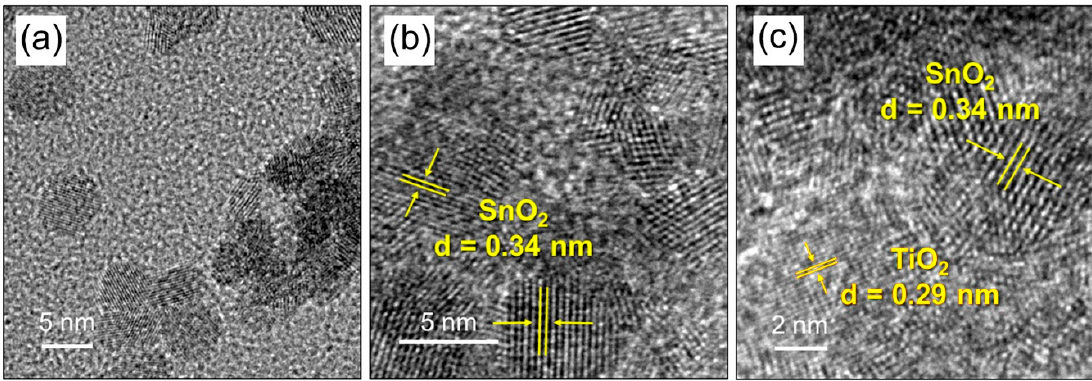
Figure 3. ( a ) TEM and ( b ) Lattice resolved TEM image of SnO 2 powder used as a substrate in ALD synthesis; ( c ) Lattice-resolved TEM image of SnTi-1 nanocomposite.